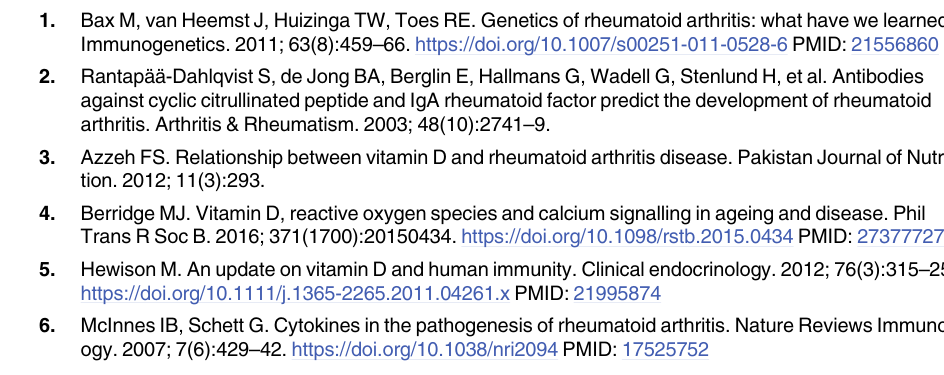
S1 File. Biochemical markers and inflammatory cytokines in RA patients. Table A. Com- parison of biochemical markers and inflammatory cytokines in seronegative and seropositive RA patients. Table B. Comparison of biochemical markers and inflammatory cytokines in RA patients having DAS (cid:20) 3.2 and those having DAS >